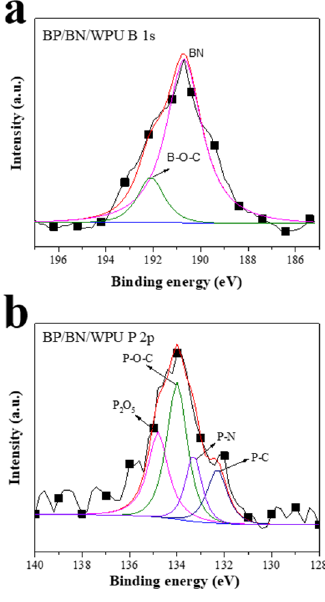
Figure 6. XPS spectra of the residue of BP / BN / WPU composite material after CC test; ( a ) high-resolution Figure 6. ( a ) XPS spectra of the residue of BP/BN/WPU composite material after CC test; XPS spectra of B 1s of the residue of BP / BN / WPU composite material; ( b ) high-resolution XPS spectra ( b ) high- resolution XPS spectra of P 2p of the residue of BP/BN/WPU composite material; of P 2p of the residue of BP / BN / WPU composite ( c ) high- resolution XPS spectra of B 1s of the residue of BP/BN/WPU composite material.